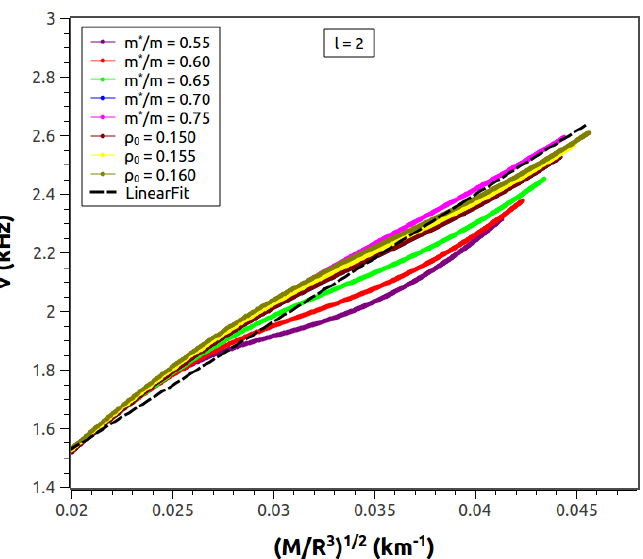
Figure 9. The l = 2 f -mode frequencies as a function of ( M / R 3 ) 1/2 for varying ρ sat and m ∗ / m . The black solid line gives the linear fit to the